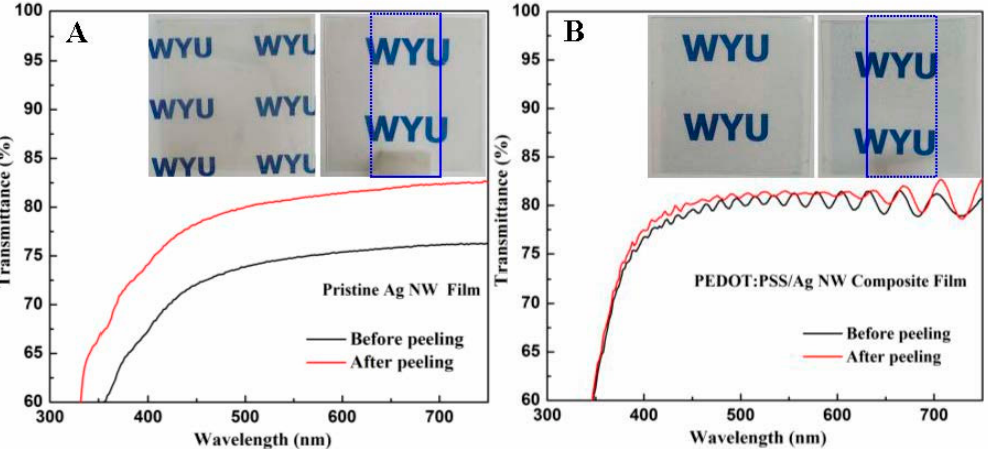
Figure 5. Optical transmittance spectra of the pristine Ag NW film ( A ) and the PEDOT:PSS/Ag NW composite film ( B ) before and after peeling of the tape, the insets show photographs of the films, and the blue dotted rectangles correspond to the peeling areas.